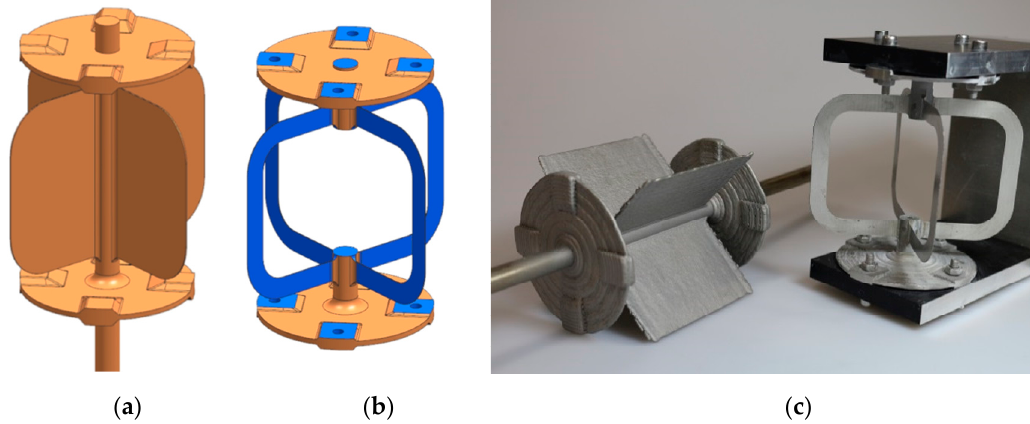
Figure 29. ( a ) CAD model AM part, ( b ) CAD model flexure pivot, ( c ) generated semifinished part with LMD (left) and final flexure pivot for demonstrator testing (right).